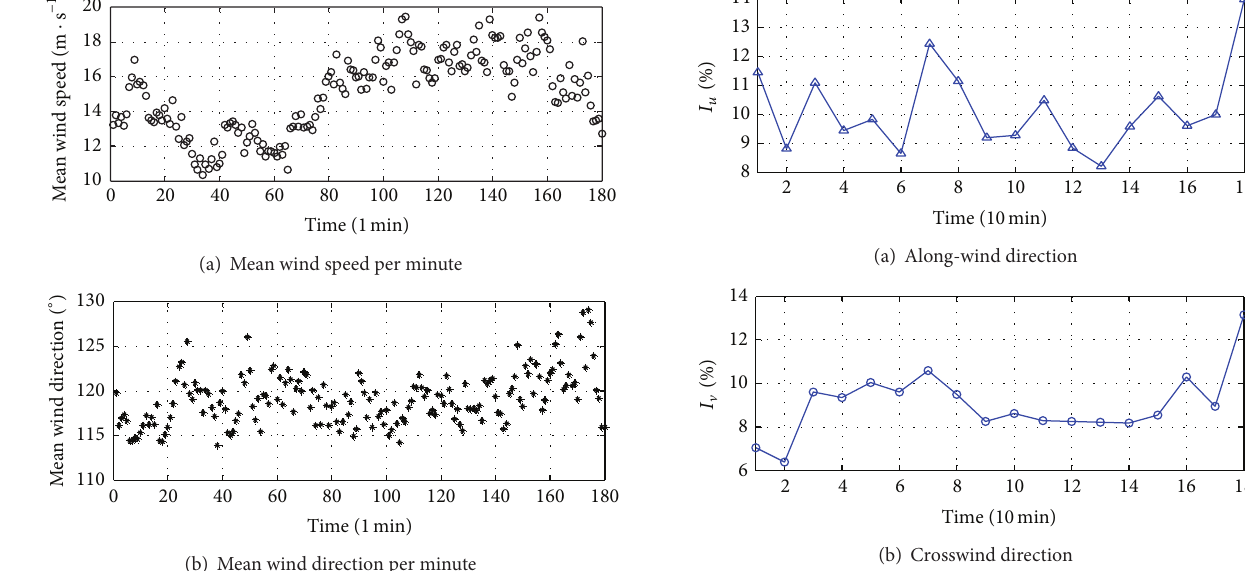
Figure 8: Mean wind speed and the direction of Typhoon Fung- Wong.